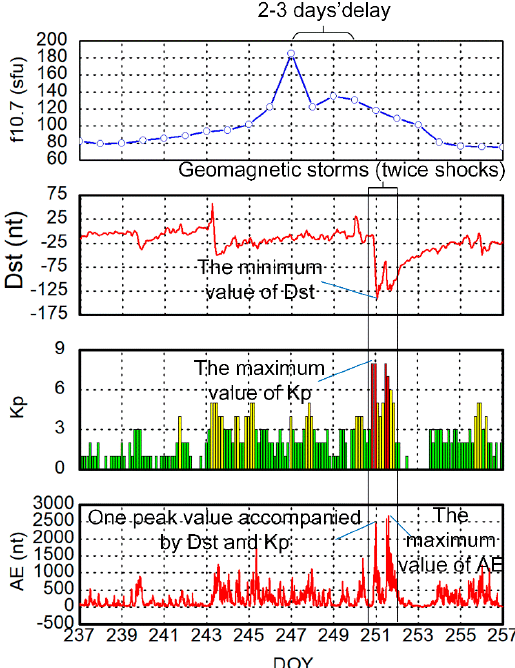
Figure 2. The solar and geomagnetic index series from day of year (DOY) 237 to 257 in 2017. The solar storms occurred on DOY 247–249 and the geomagnetic storms occurred on DOY 250–252.